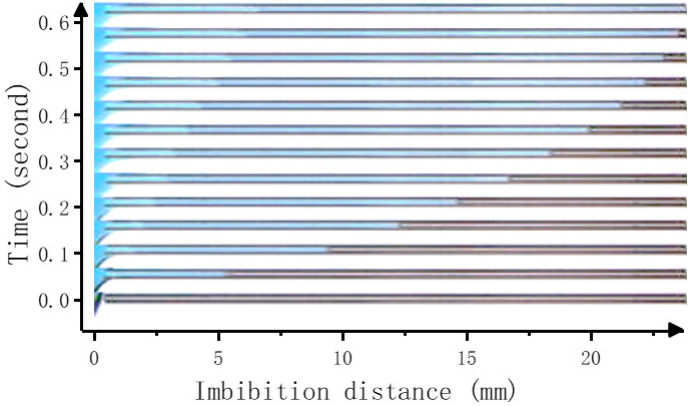
Figure 1. Imbibition that DI-water displaces air in one single channel.